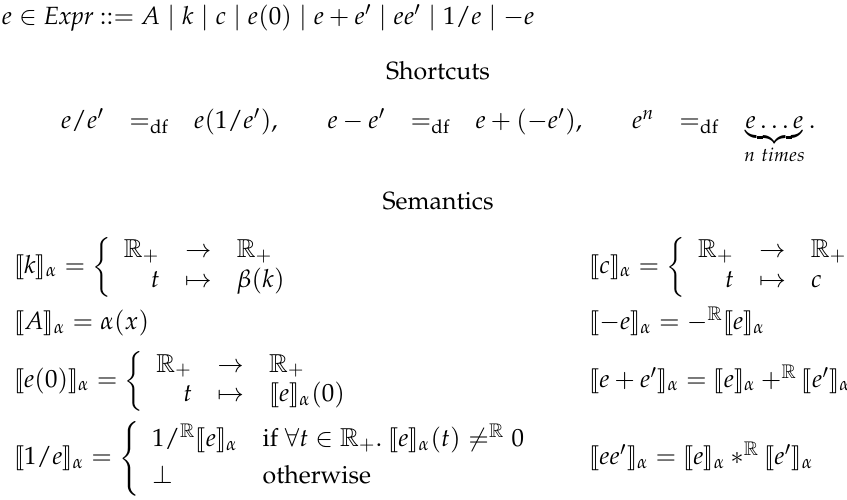
Figure 11. Expressions where A ∈ Spec , k ∈ Param , c ∈ R , and n ∈ N